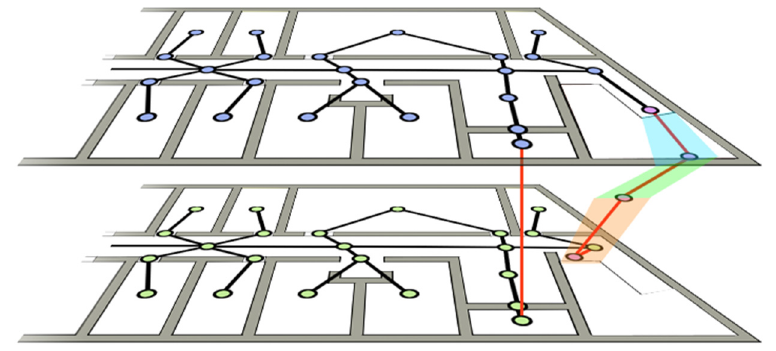
Figure 4. An example of an indoor map.